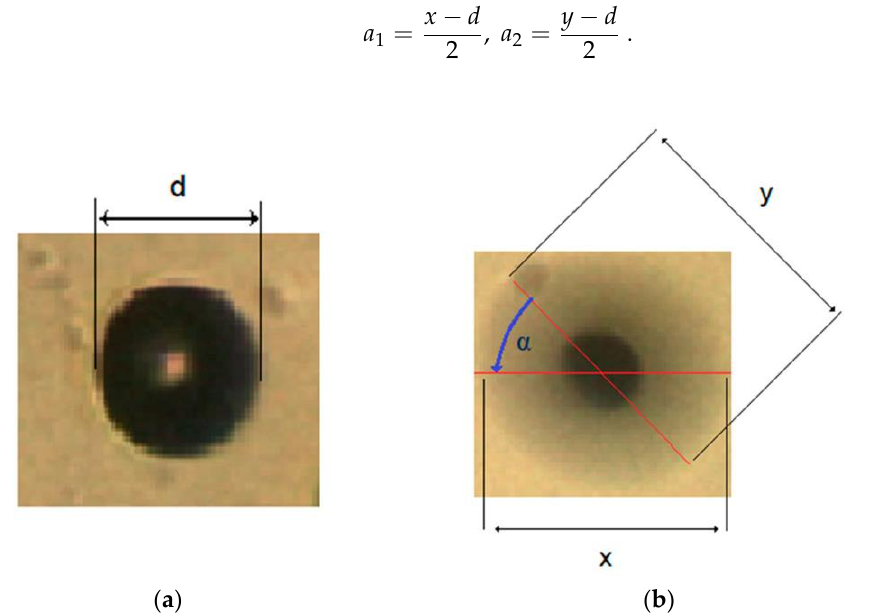
Figure 11. Measurements of vibration amplitudes and phase shift between directions of vibration amplitude: ( a ) Piezo actuators are switched off. ( b ) Piezo actuators in both x and y directions are switched on.